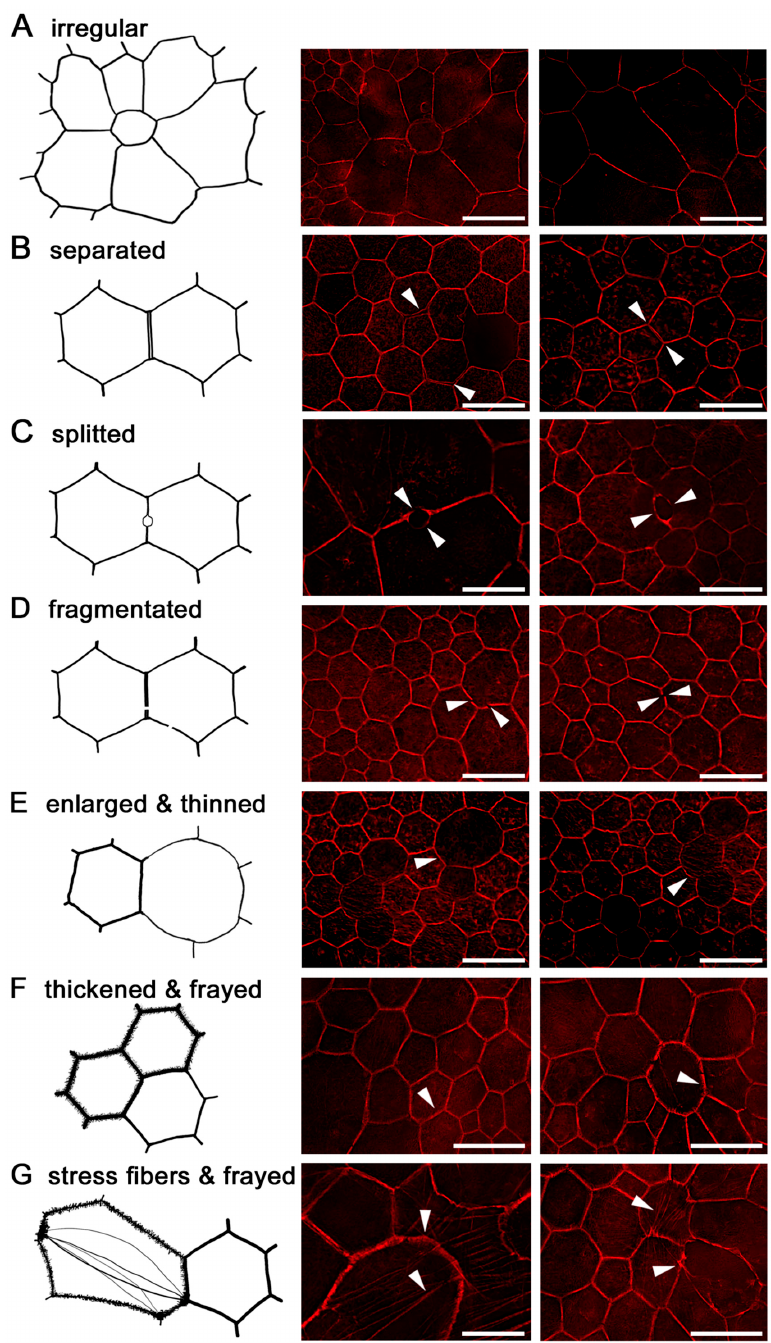
Figure 4. Cytoskeleton changes in AMD-affected eyes. In AMD, RPE cells and the cytoskeleton undergo significant changes. Drawings and photomicrographs show different cells with similar characteristics. ( A ) The loss of the cytoskeletons’ regular polygonal geometry and shape: enlarged cells with partly roundish cell shape and very variable cell sizes. ( B ) The separation of adjacent cells’ cytoskeleton bands. ( C ) The focal splitting of the cytoskeleton of two adjacent cells. These alterations are tiny in the beginning, but progress over time and can lead to a complete separation of two RPE cells. ( D ) Cytoskeleton fragmentation with dislocated free ends. Noticeably, the cell shape of these cells appears to be only minimally affected. ( E ) Enlarged RPE cells with a partly or complete thinned F-actin. ( F ) A thickened and frayed F-Actin. ( G ) In affected RPE cells, multiple intracellular stress fibers may appear. At sites where stress fibers insert, the cytoskeleton also appears frayed and thickened. Scale bar: 20 µ